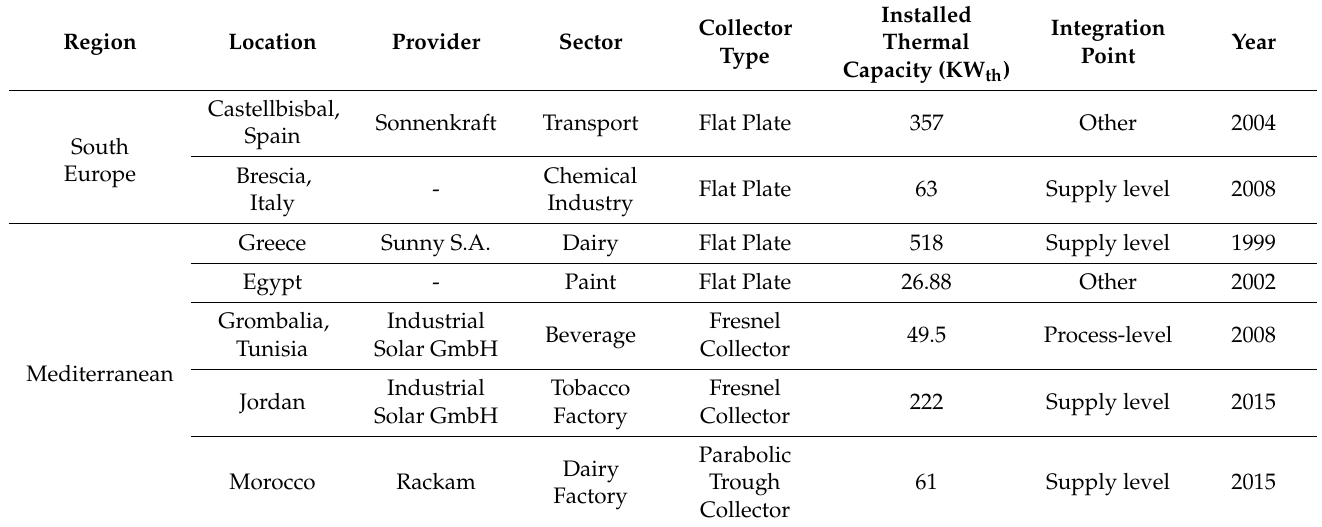
Table 7. Solar process heat integration in southern Europe and Mediterranean